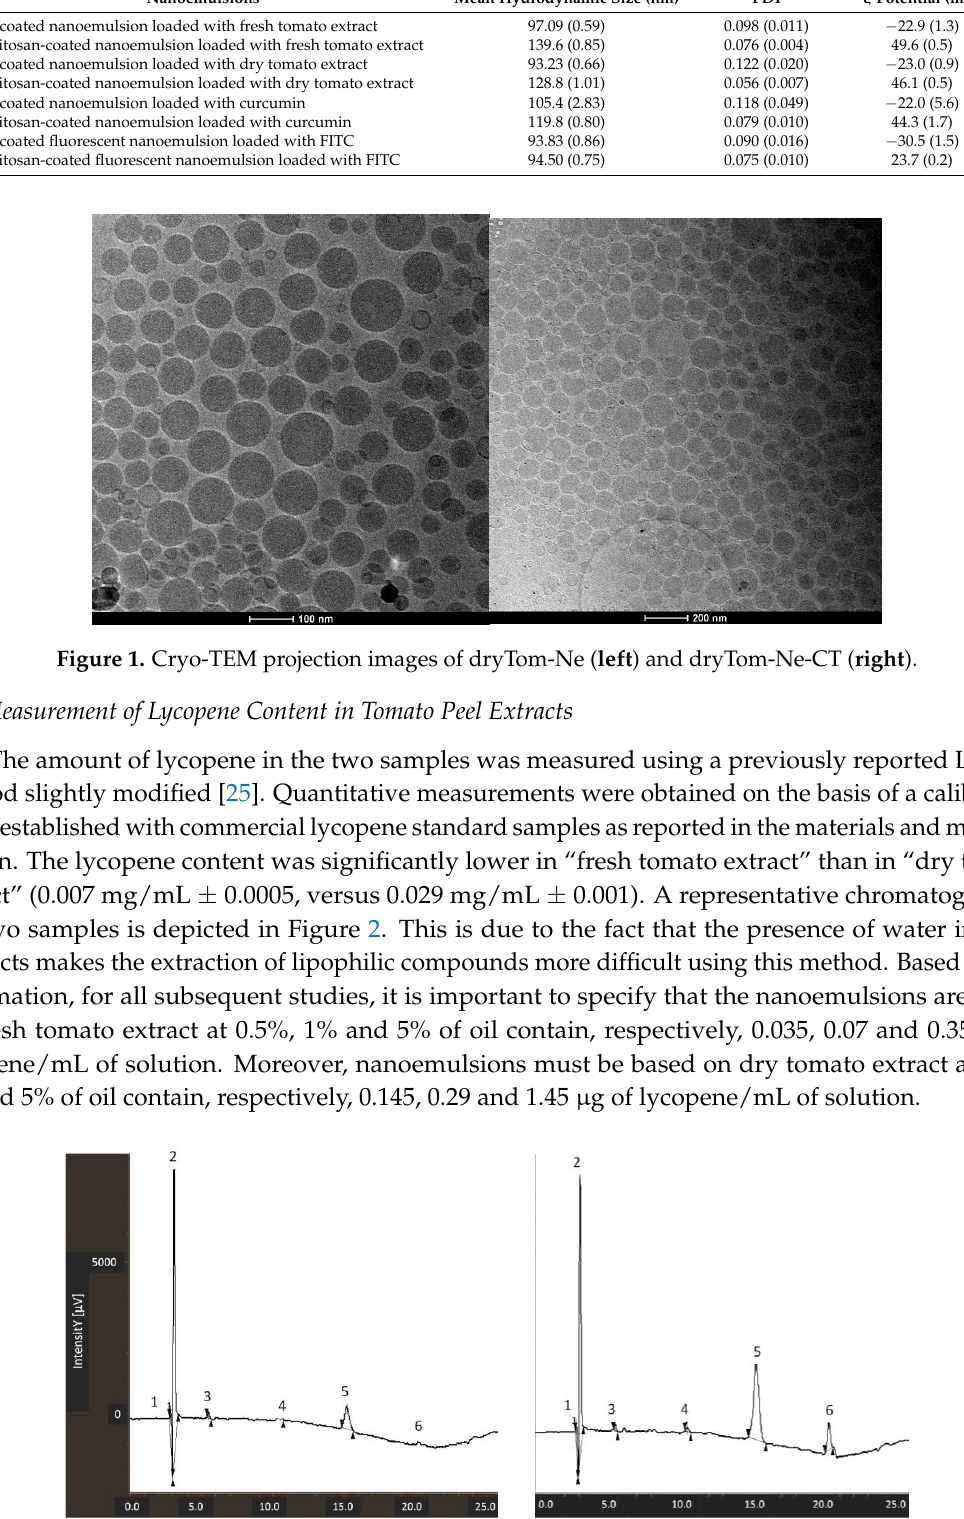
Figure 2. Representative chromatograms for the samples “dry tomato extract” ( left ) and “fresh tomato extract” ( right ). Lycopene is peak n. 5.